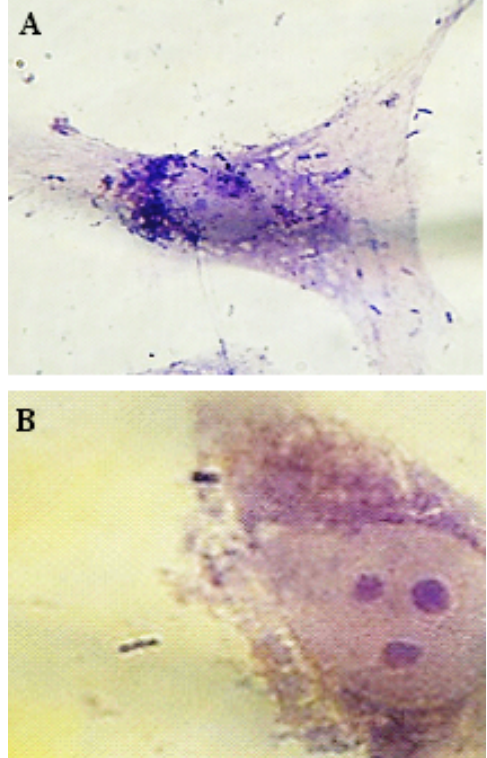
Figure 1: Gentamicin-HEp-2 cell invasion assay. Intracellular localization of S.sonnei(A) and S.flexneri(B) in HEp-2 cell